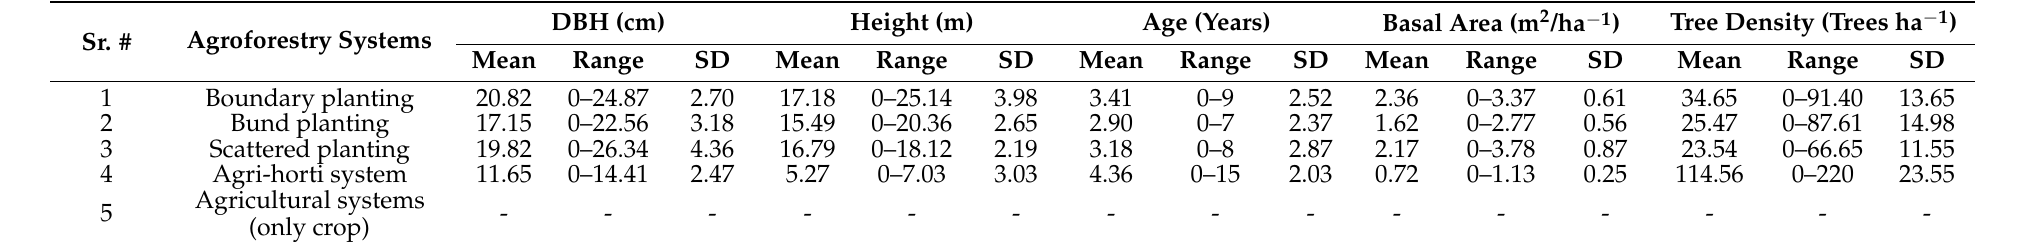
Table 2. Growth parameters (mean ± SD) of poplar trees of different agroforestry systems in the semi-arid